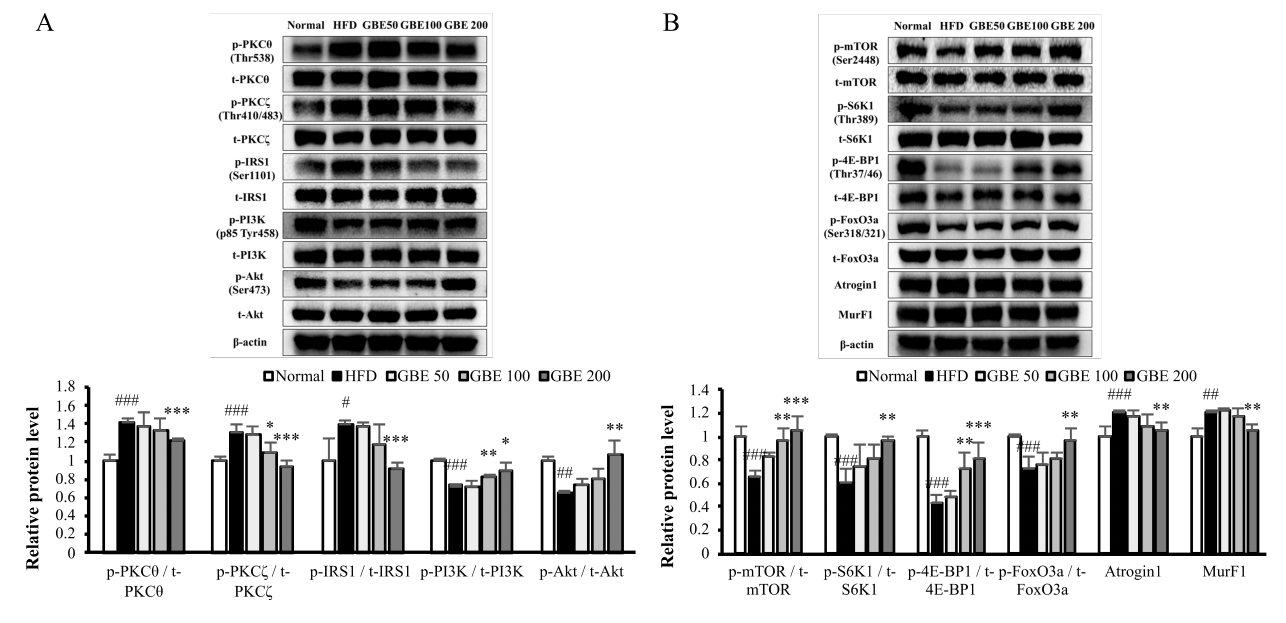
Figure 5. GBE administration up-regulated the PI3K/Akt pathway through inactivation of PKC θ and PKC ζ . ( A ) The changes in upstream factors of PI3K/Akt pathway. ( B ) The changes in downstream factors of PI3K/Akt pathway. The protein expression levels were normalized to the β -actin level. Data are expressed as mean ± SD. # p < 0.05, ## p < 0.01 and ### p < 0.001 versus the normal group. * p < 0.05, ** p < 0.01, and *** p < 0.001 versus the HFD group.